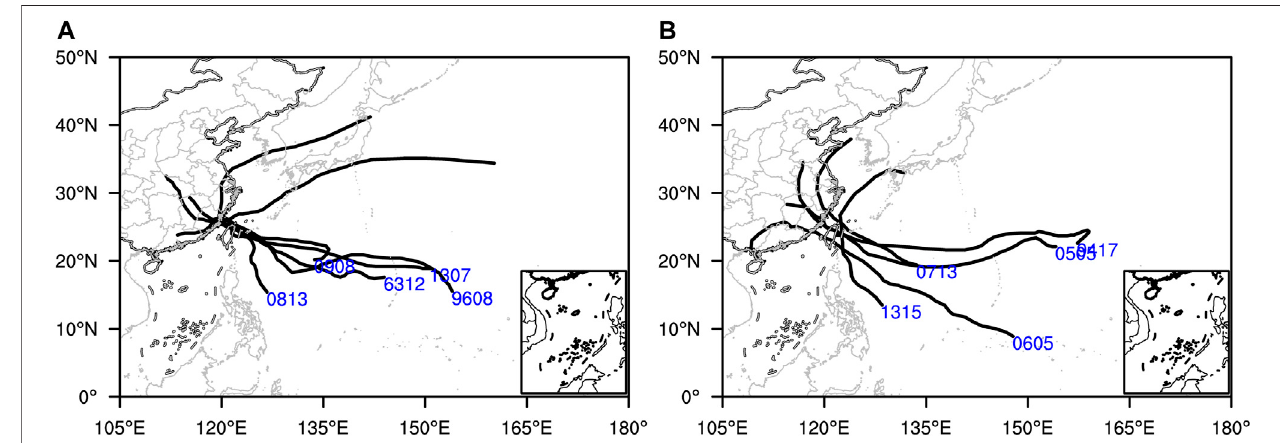
FIGURE1| Tracks (blackthicksolidlines)oftheselected (A) ERLTCand (B) NERLTCtyphooncases. Thebluenumbersrepresenttheserialnumber(the yearand the numbering of the TC in that year — for example, 0813 means the year 2008 and the 13th TC in 2008) of each TC.